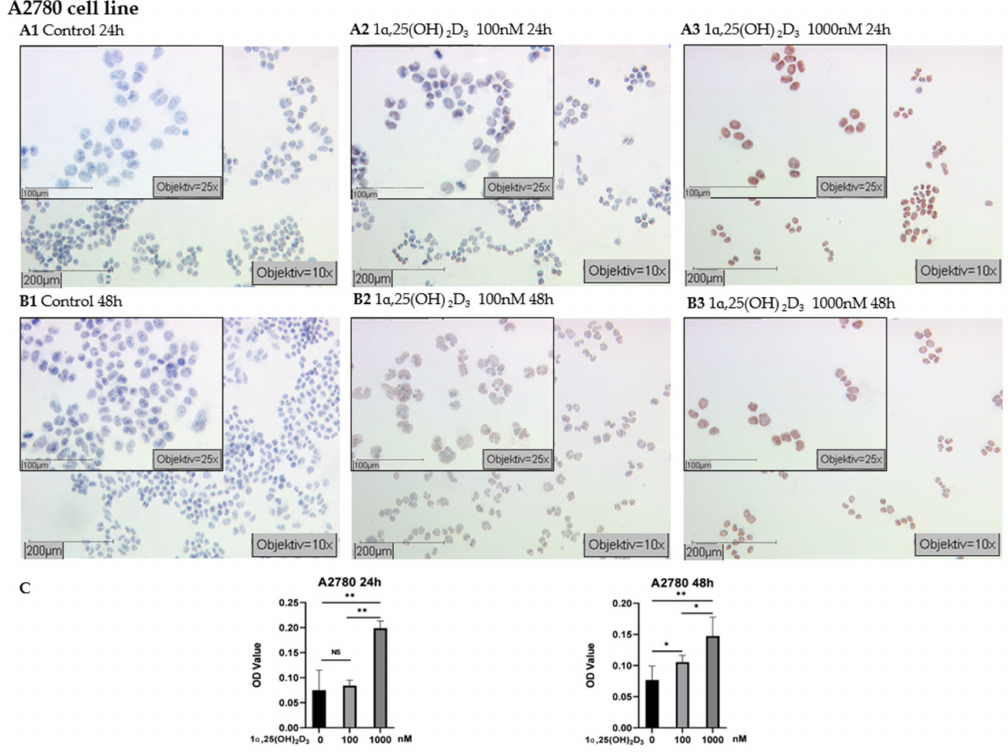
Figure 4. Detection of H3K4me3 with immunocytochemistry in A2780 cell line: ( A ) representative pictures of H3K4me3 immunocytochemistry staining of A2780 cells treated with 1 α ,25(OH) 2 D 3 at di ff erent concentrations for 24 h (A1 control; A2 100 nM 1 α ,25(OH) 2 D 3 ; A3 1000 nM 1 α ,25(OH) 2 D 3 ); ( B ) representative pictures of H3K4me3 immunocytochemistry staining of A2780 cells treated with 1 α ,25(OH) 2 D 3 at di ff erent concentrations for 48 h (B1 control; B2 100 nM 1 α ,25(OH) 2 D 3 ; B3 1000 nM 1 α ,25(OH) 2 D 3 ) (scale bars 200 µ m, small pictures 100 µ m); ( C ) ImageJ-based quantification